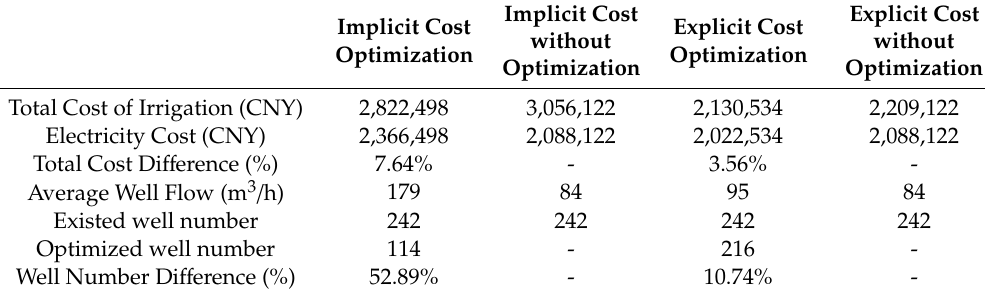
Table 3. Results of the optimization